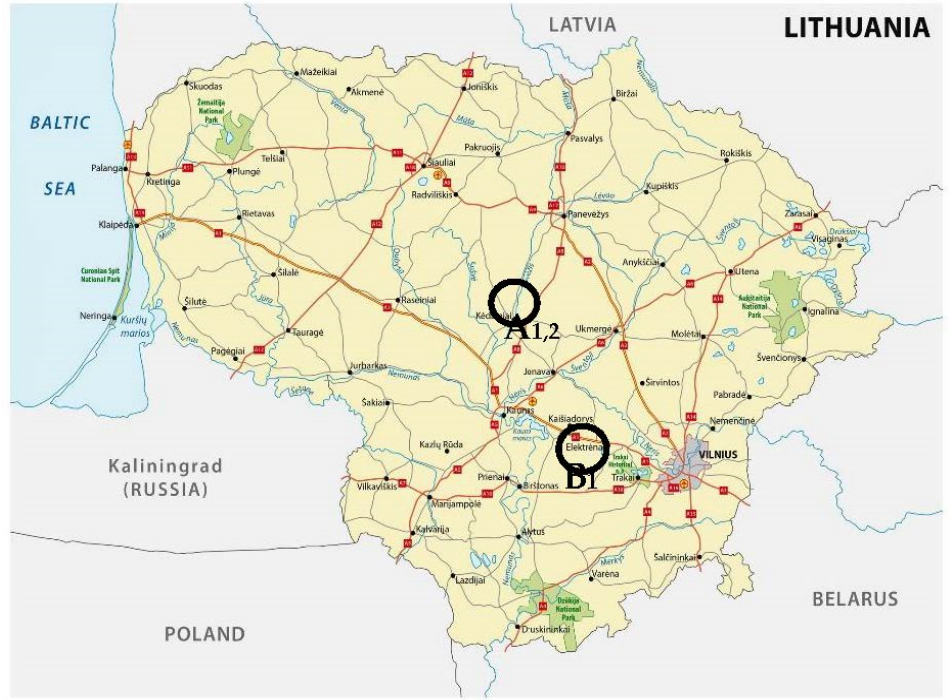
Figure 1. Experimental sites. The three field experiments’ locations. A 1,2 —two field experiments in K˙edainiai district, the Fluvisol soil type. A 1 —the land-use system of semi-natural grassland, A 2 —the field of crop rotation (cereals were grown), B 1 —the field experiment in Elektrenai district, the Retisol soil type and semi-natural grassland